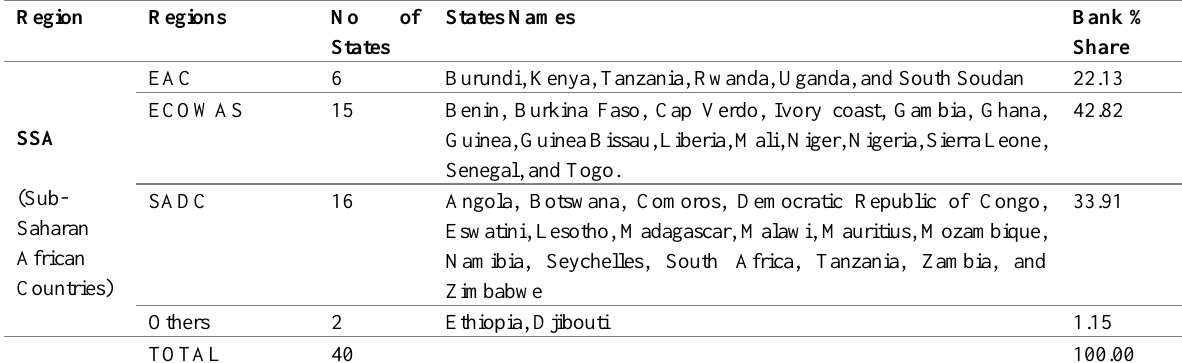
Table 2: The Study Region: Ssa African (Sub-Saharan African Countries)